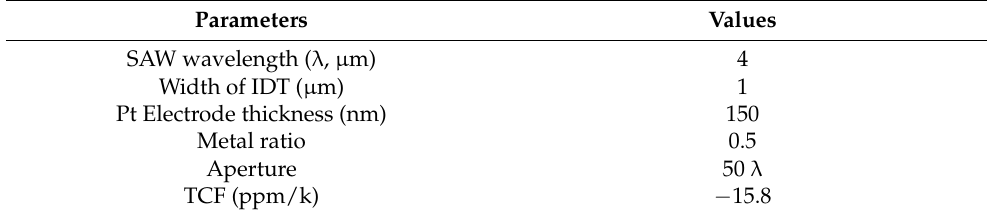
Figure 2. Properties of the LGS substrate. ( a ) Acoustic velocity distribution. ( b ) Temperature response of SAW sensors with λ = 4 µ m along different propagation directions ϕ . Table 2. The parameters of the resonators of LGS.